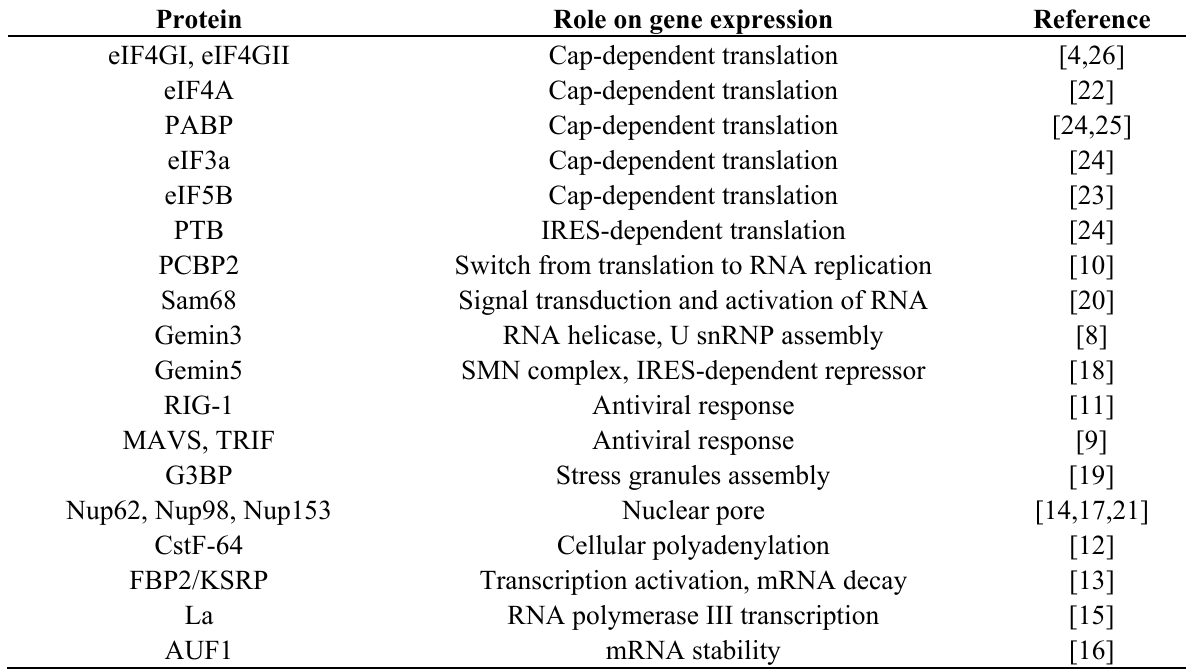
Table 1. RNA-binding proteins proteolyzed in picornavirus infected cells.